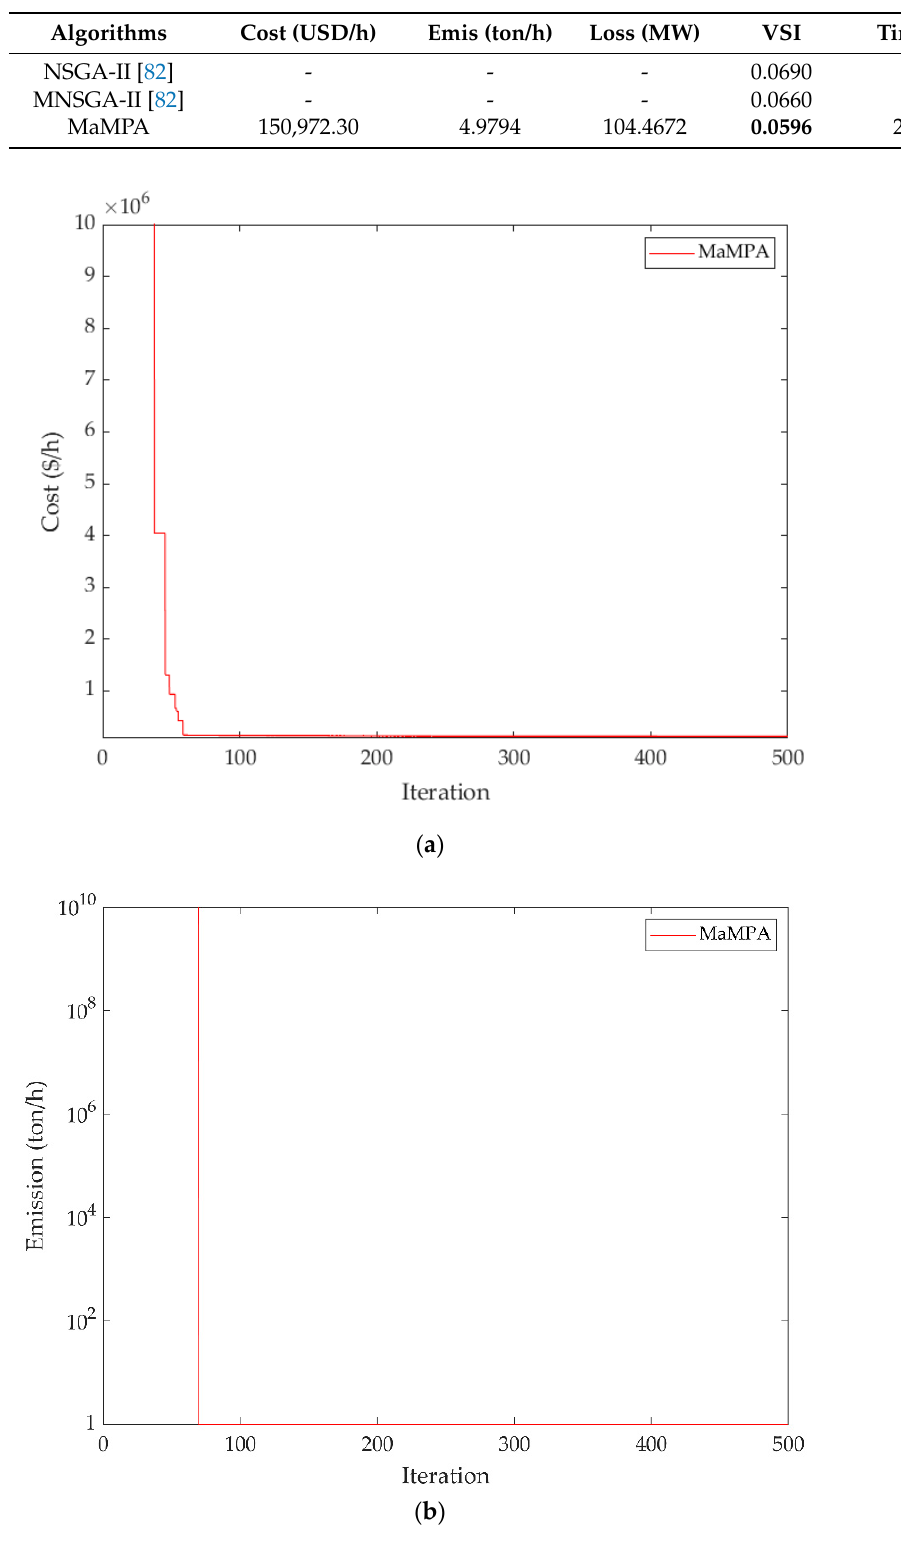
Table 8. Comparison results of case 8.